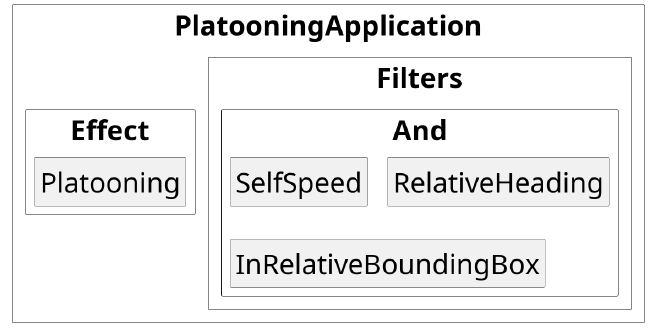
Figure 5. Platooning app configuration.